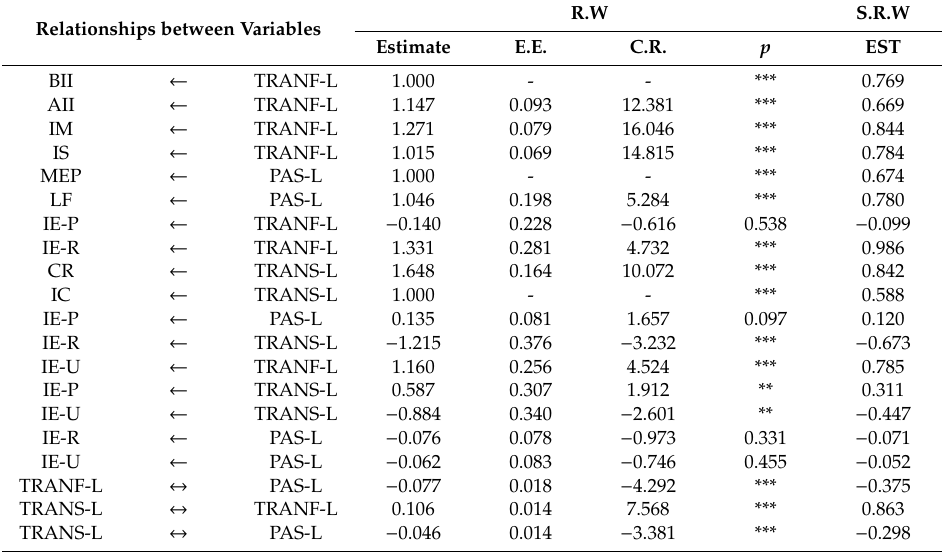
Table 2. Regression weights and standardized regression weights for inferior teaching.